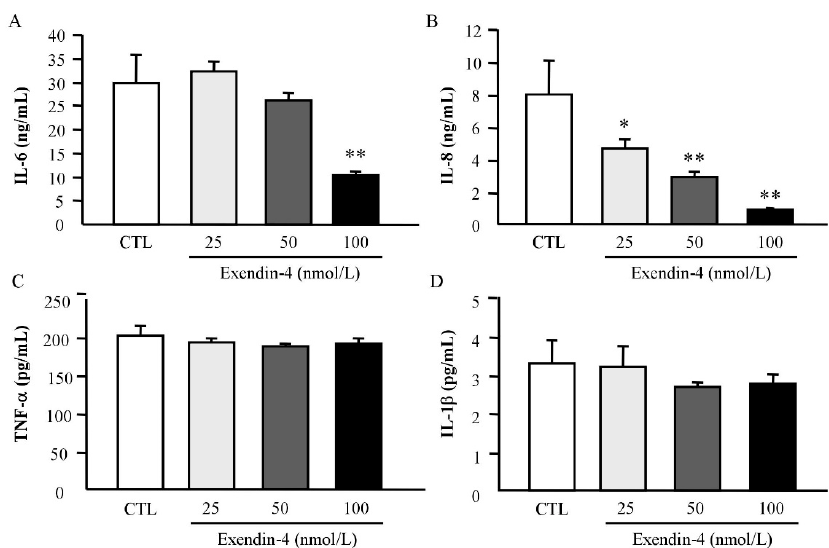
Figure 2. Exendin-4 reduces the expression of pro-inflammatory genes in human visceral adipocytes. ( A ) Gene expression levels of inflammatory factors (monocyte chemoattractant protein-1 ( CCL2 ), interleukin ( IL)-1B , IL6 , IL8 and tumour necrosis factor- α ( TNF )) and ( B ) anti-inflammatory factors (adiponectin ( ADIPOQ ), IL4 , kruppel-like factor 4 ( KLF4 ), arginase 1 ( ARG ) and peroxisome proliferator activated receptor- γ ( PPARG )] in human visceral adipocytes stimulated with exendin-4 (25, 50 and 100 nmol/L) for 24 h. Gene expression levels in unstimulated cells were assumed to be 1. Values are the mean ± SEM ( n = 6 per group). Differences between groups were analyzed by one-way ANOVA followed by Dunnett’s tests. * p < 0.05, ** p < 0.01, *** p < 0.001 vs. unstimulated cells.